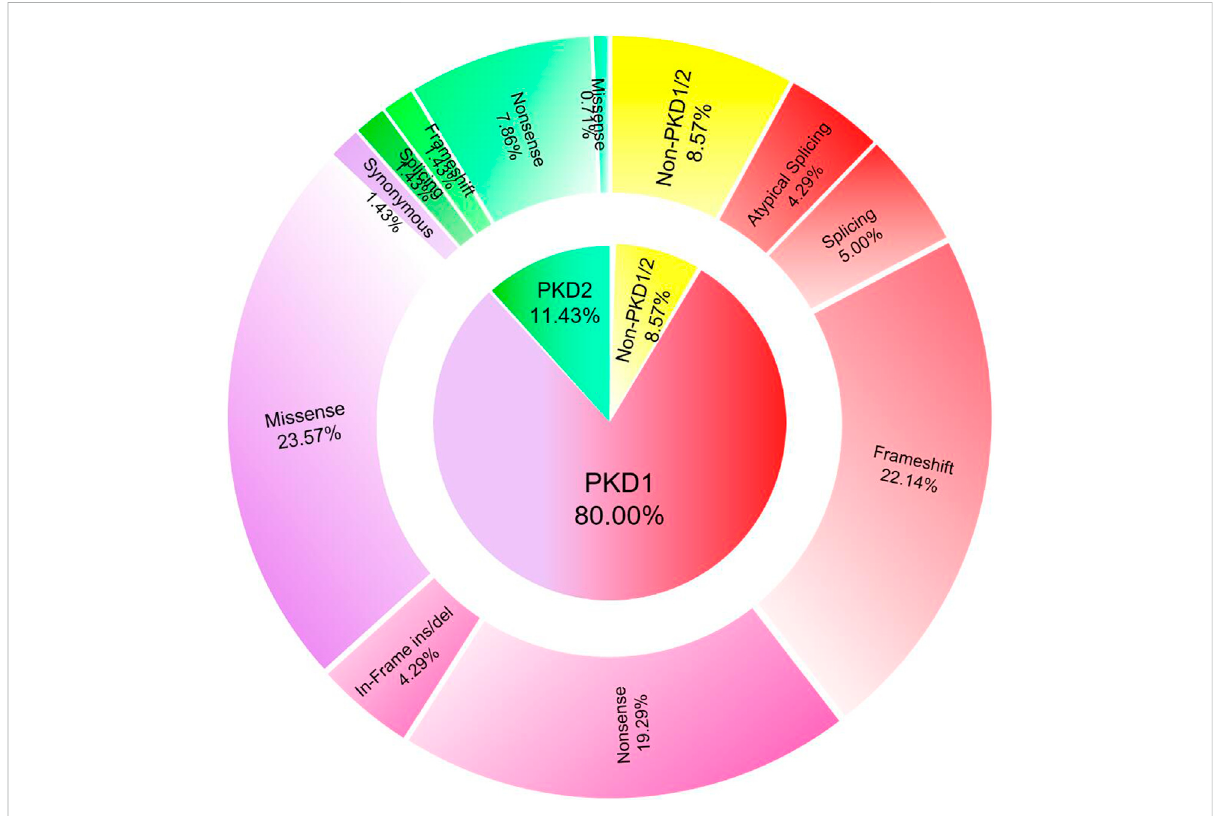
FIGURE 1 Distribution of genotypes and mutation types in ADPKD patients included in this